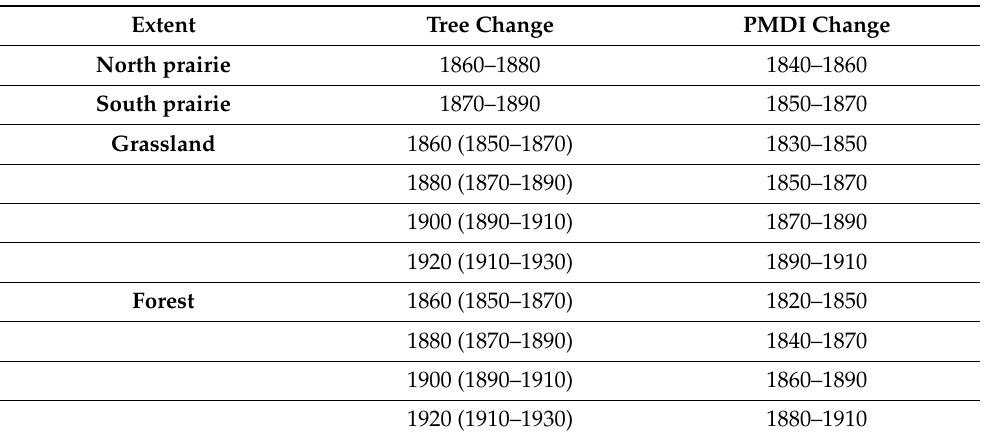
Table 1. Approximate decades of tree change in density and diversity and expected preceding Palmer Modified Drought Index (PMDI) change for two prairie provinces based on historical records and for grassland and forest areas after reaching the threshold of 25% agriculture. Extent Tree Change PMDI Change North